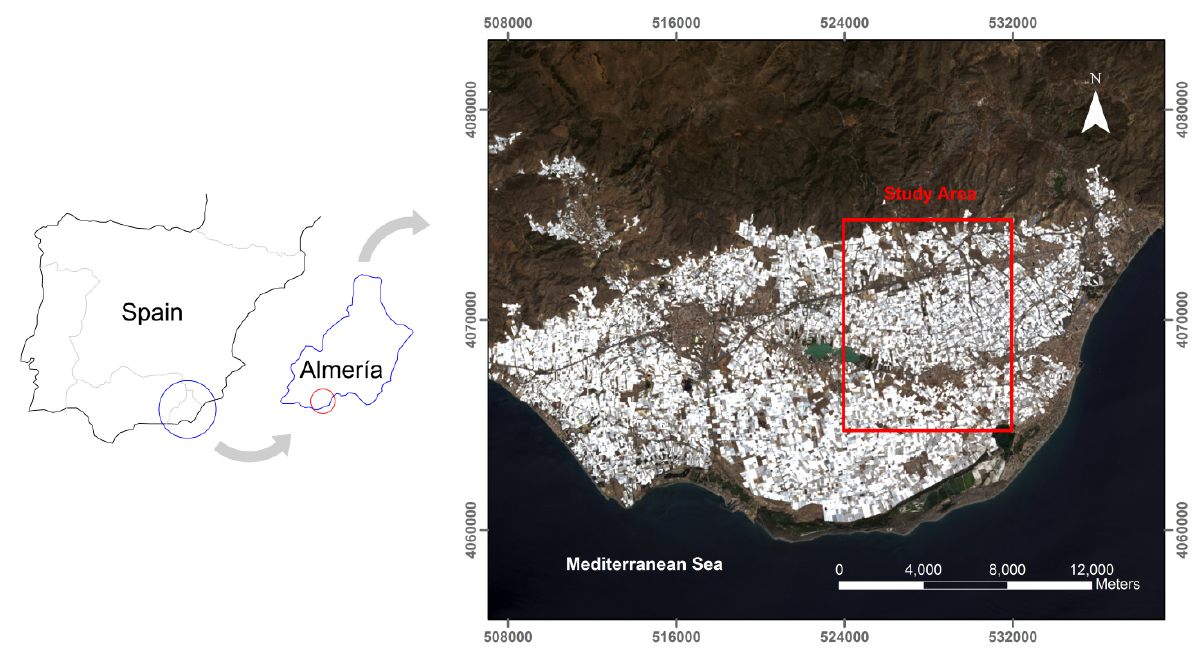
Figure 1. Location of the study area on a RGB Landsat 8 image taken in August 2013, covering the “Poniente” region. Coordinate system: ETRS89 UTM Zone